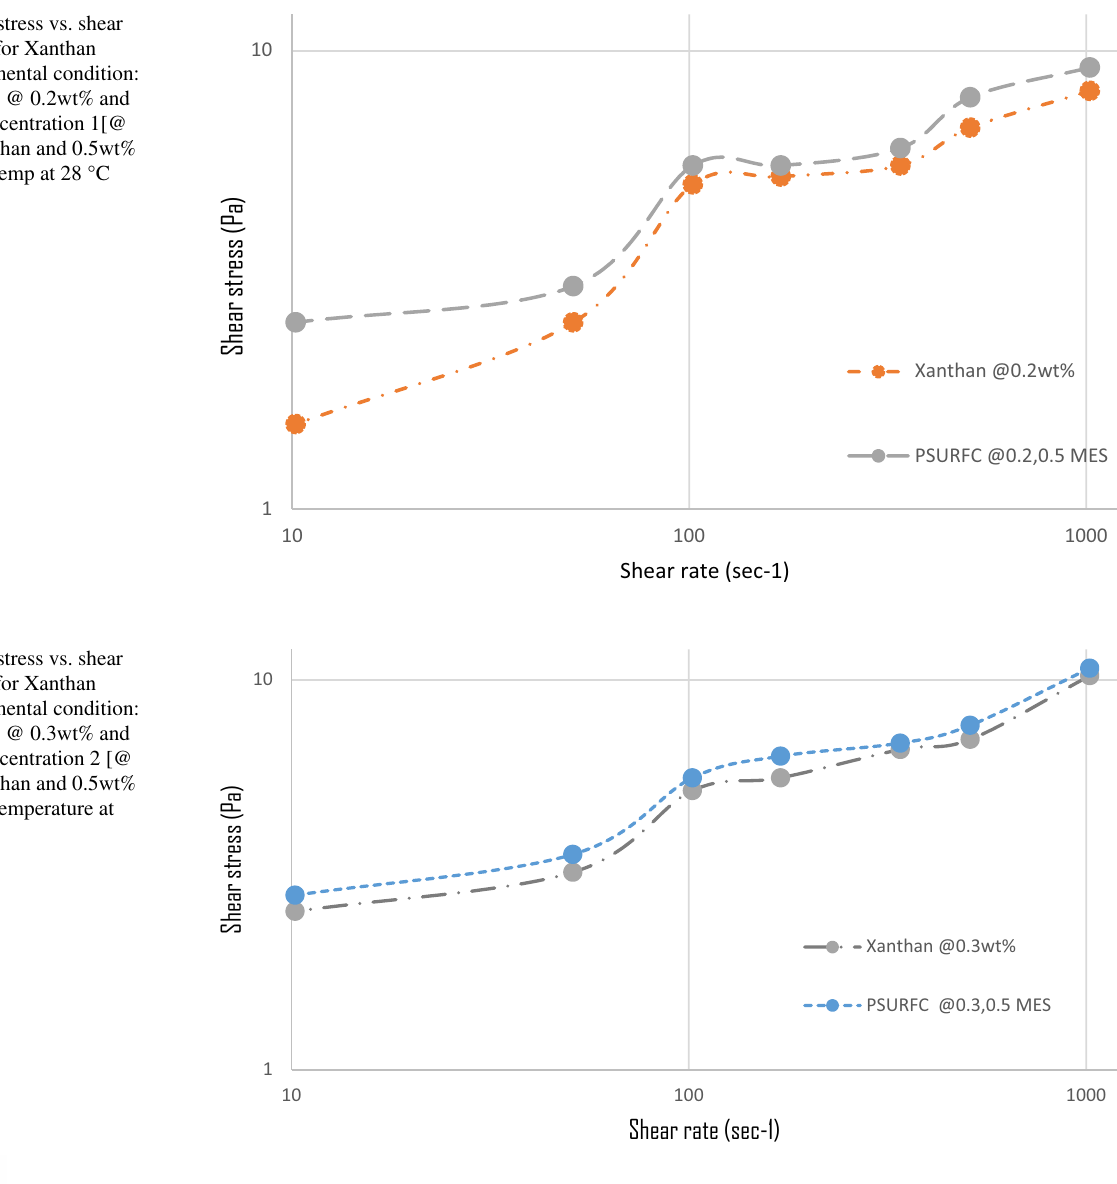
Fig. 2 Shear stress vs. shear